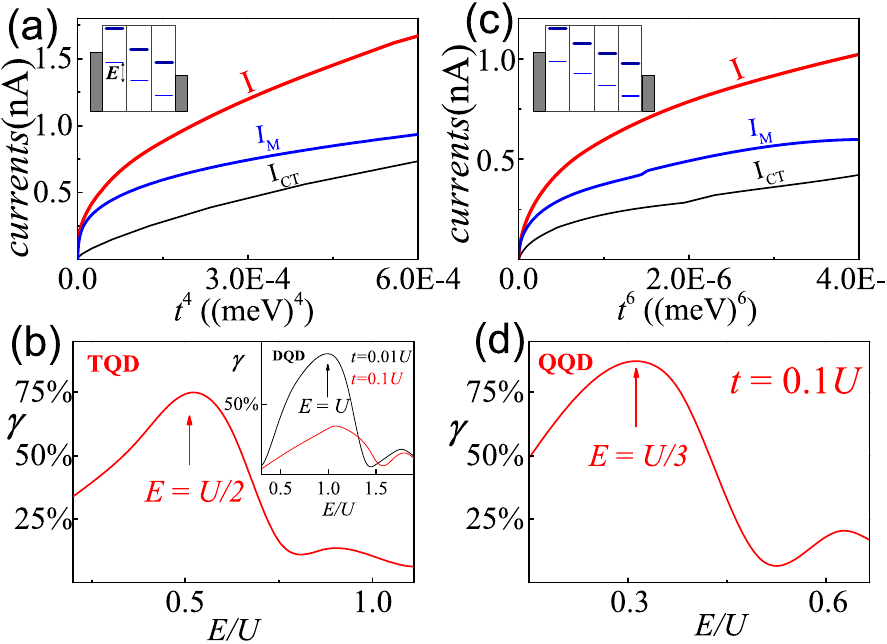
Figure 5. ( a ) The dependence of I , I M and I CT on t 4 at eV = 1.5 meV for the TQDs with tilting energy E = U /2. ( b ) The dependence of γ ≡ ( I M /1) × 100% on the ratio of E / U in the TQDs at t = 0.1 U is displayed. The insert shows γ as a function of E / U in the DQDs at t = 0.01 U and 0.1 U . ( c ) The I , I M and I CT vary with t 6 at eV = 1.5 meV for the QQDs with E = U /3. ( d ) The γ as a function of E / U is depicted for the QQDs at t = 0.1 U . The other parameters are T = 0.1